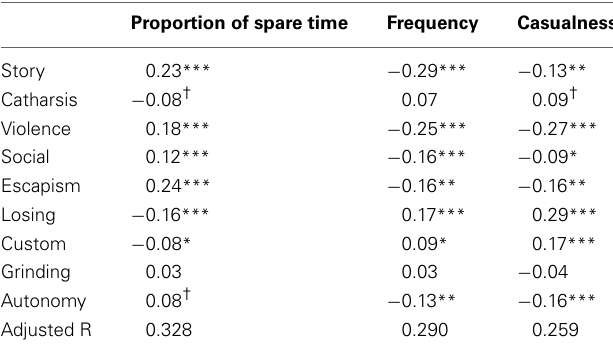
Table 7 | Relationships between GAMES factors and patterns of game